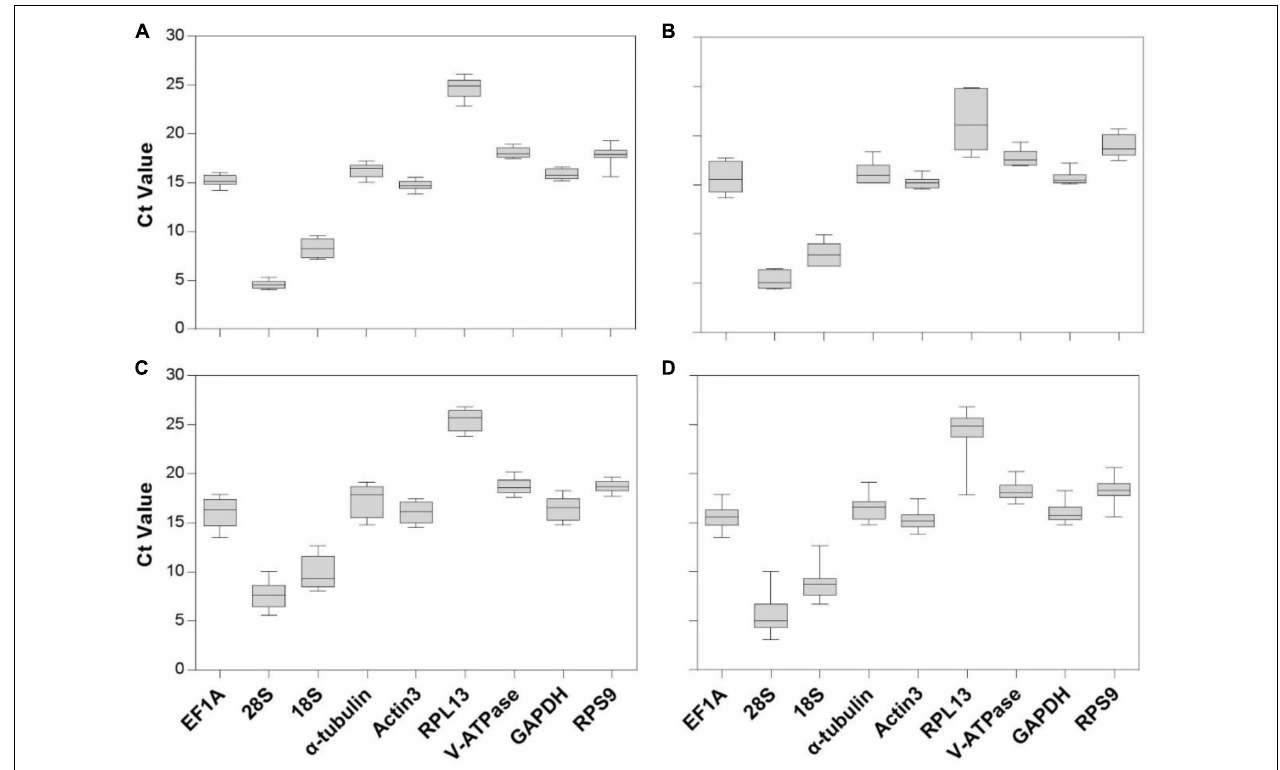
FIGURE 1 | Expression range of Ct values of candidate reference genes under different intrinsic conditions in A. viennensi . The intrinsic conditions included different developmental stage (A) , sex (B) , diapause (C) , and all three conditions combined (D) . The box indicates the 25th and 75th percentiles, the line across the box represents the median, and whisker caps the maximum and minimum